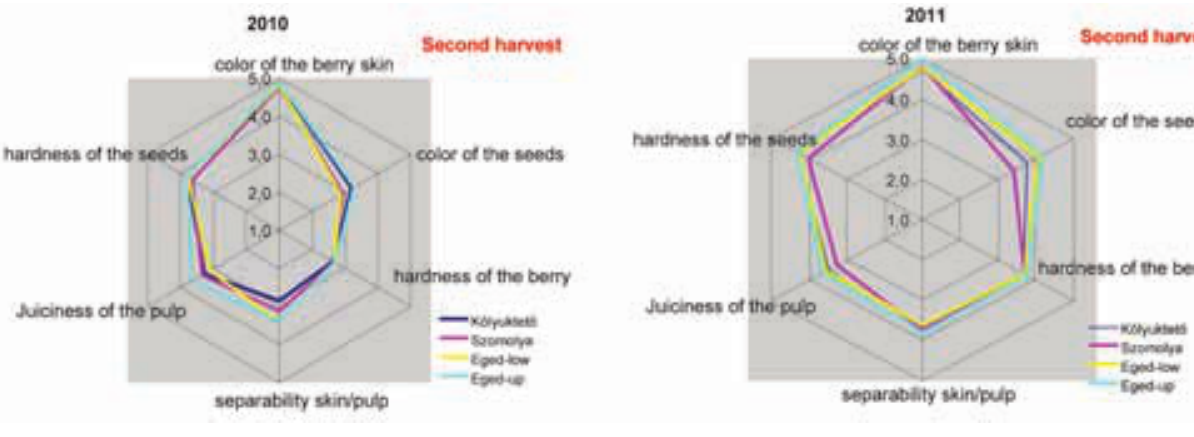
Figure 3 b: Main physical parameters of the berry (2010-2011-Second harvest time)